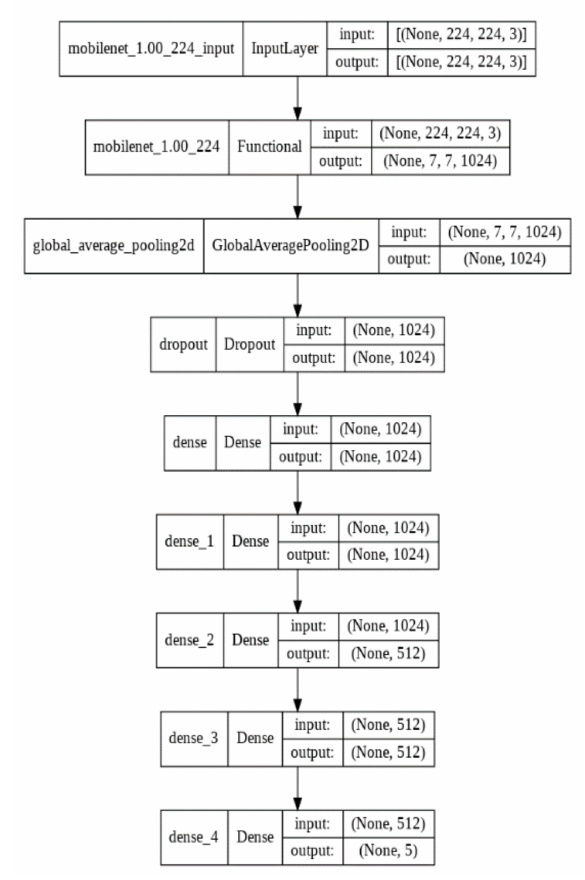
Figure 1. MobileNet V2 architecture for transfer